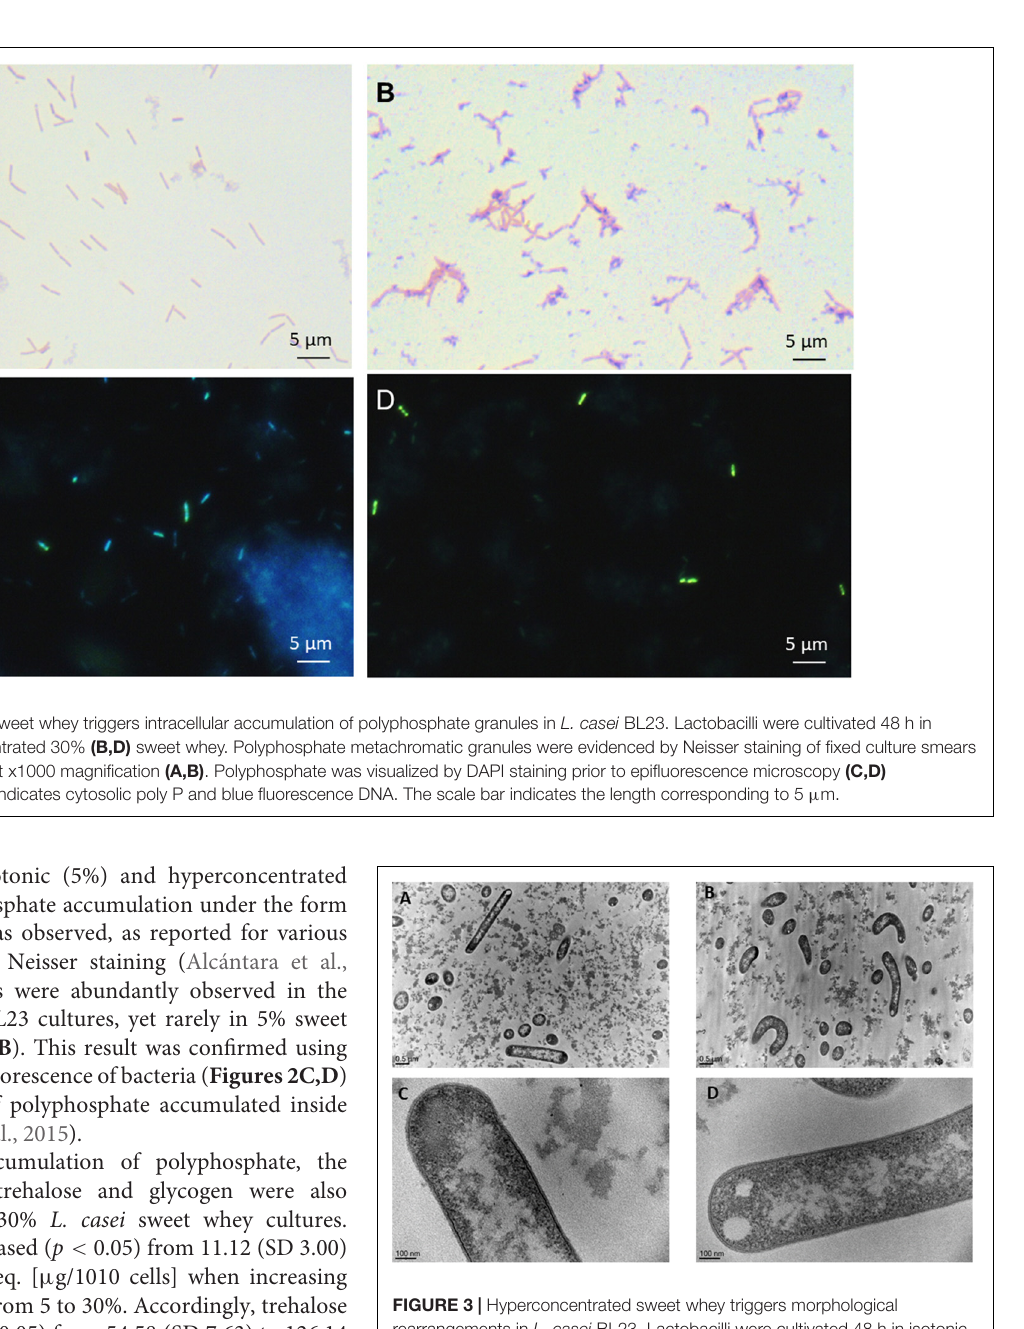
a visible curvature. There was no significant difference between the cell diameters of L. casei grown in 5 and 30% sweet whey.